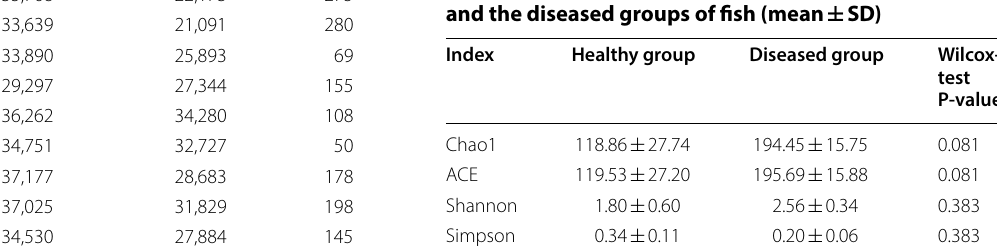
Table 2 Analysis of alpha diversity indices for the